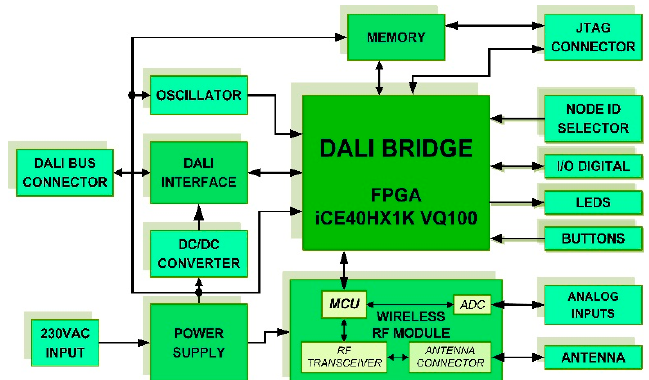
Figure 18. Block diagram of the wireless sensor node: UCODALIB.